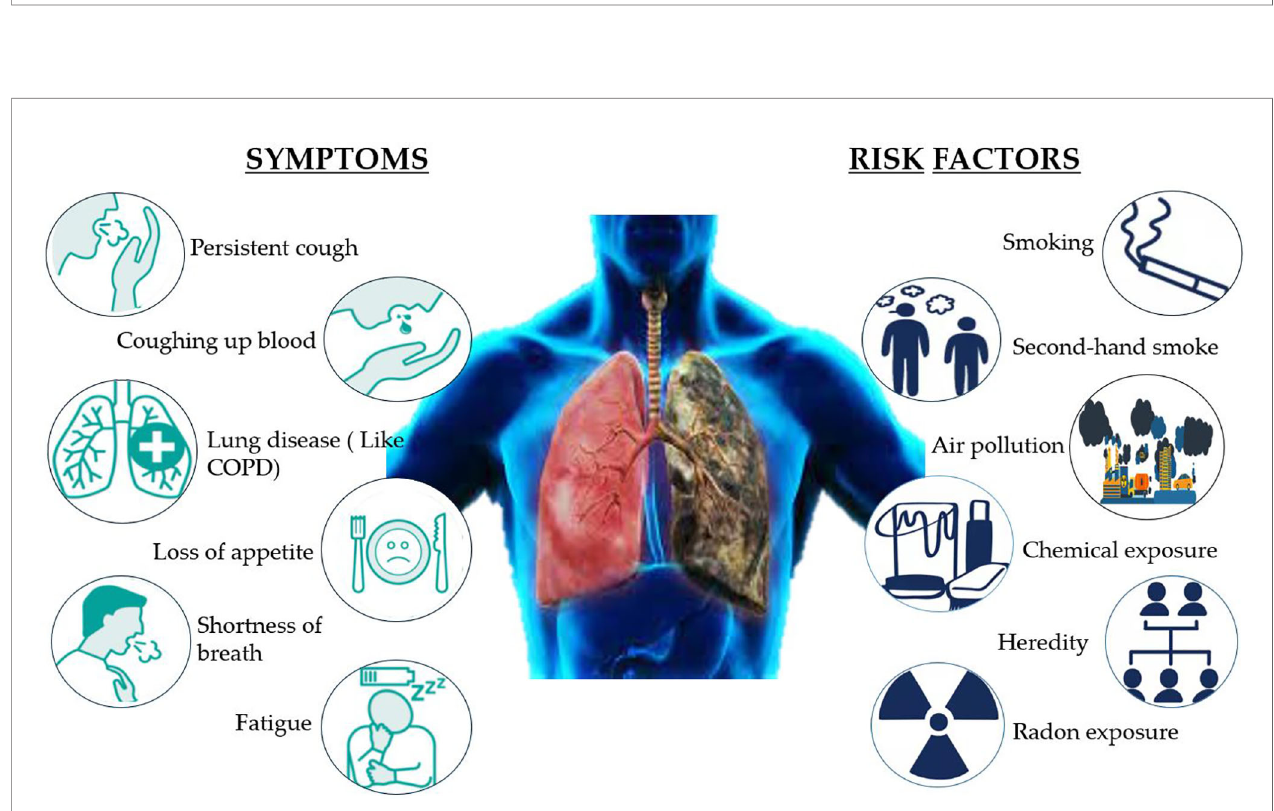
FIGURE 2 | A few symptoms and risk factors causing NSCLC in